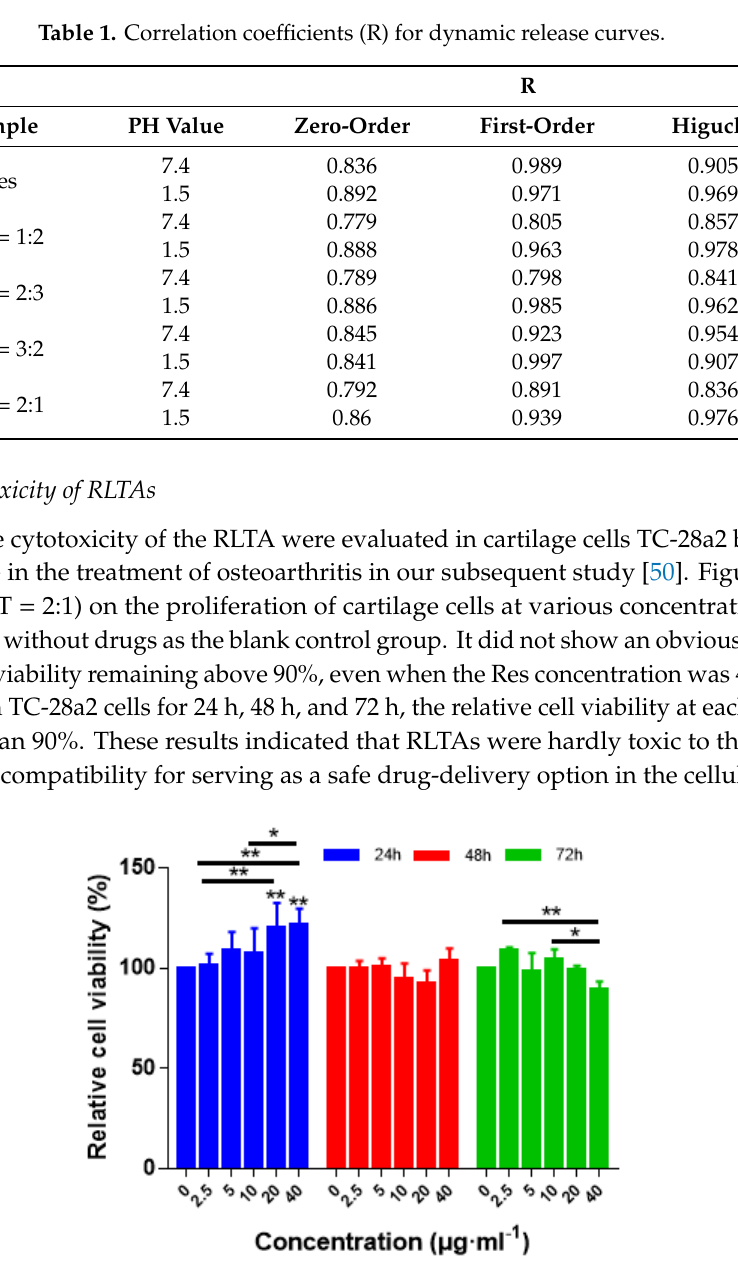
Table 1. Correlation coefficients (R) for dynamic release curves.